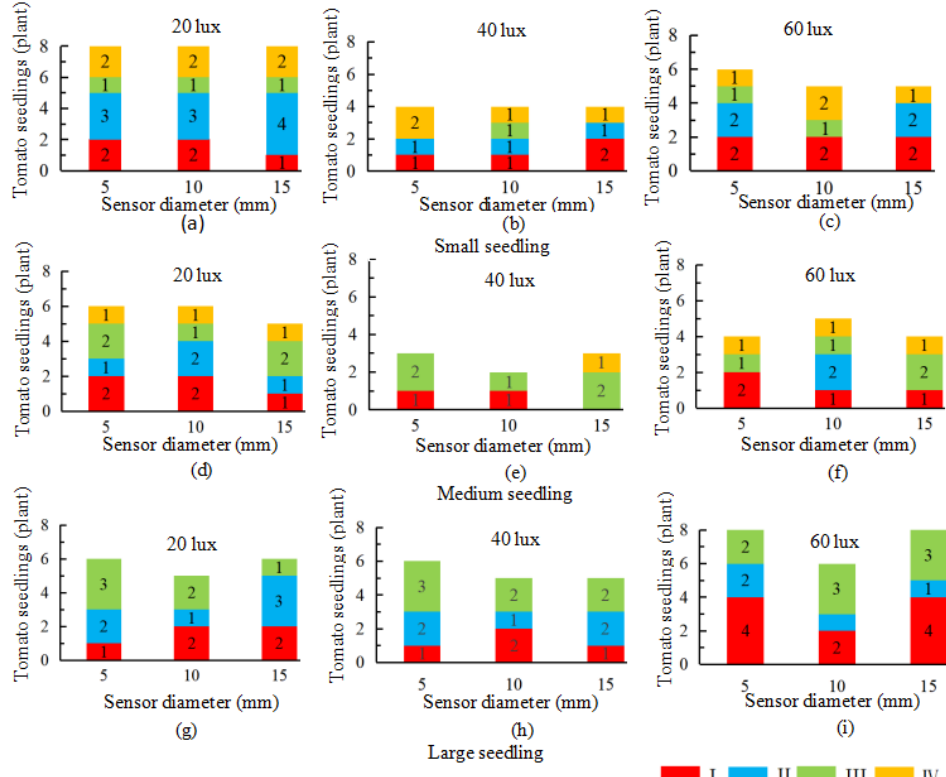
Figure 8. Reduction of the effective seedling blowing rate. Three phenomena for reducing effective Figure 8. Subfigures ( a – i ) respectively shows tomato seedlings under different Sensor diameters: Small seedling ( a – c ), Medium seedling ( d – f ), Large seedling ( g – i ). Reduction of the effective seed- seedling blowing rate are shown: (I) The seedlings blocked the sensor but did not produce an air ling blowing rate. Three phenomena for reducing effective seedling blowing rate are shown: (I) The stream; (II) The seedlings did not block the sensor but produced an air stream; (III) The subdivision seedlings blocked the sensor but did not produce an air stream; (II) The seedlings did not block the air stream did not act on the effective position of the seedling. (IV) The seedling caused the sensor sensor but produced an air stream; (III) The subdivision air stream did not act on the effective posi- to produce unstable signals and could not be affected by the subdivided air stream. The numbers tion of the seedling. (IV) The seedling caused the sensor to produce unstable signals and could not in the column chart in this figure represent the number of seedlings. ( a – i ) represents the reason for be affected by the subdivided air stream. The numbers in the column chart in this figure represent the reduction of effective seedling blowing rate under the conditions of different light intensity and the number of seedlings. sensor diameter. ( a ): small seedling; light intensity: 20 lux; senser diameter: 5–15 mm; ( b ):